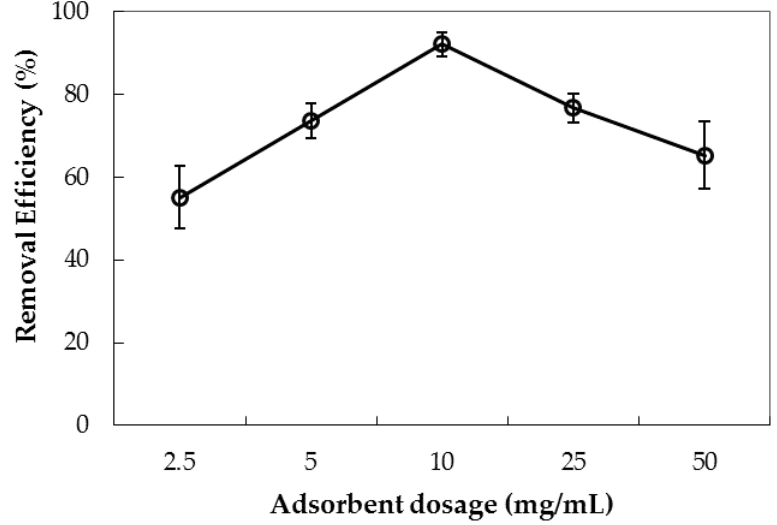
Figure 14. Influence of adsorbent dosage on removal of AMX using PMS. Error bars show standard deviations of three replicates.